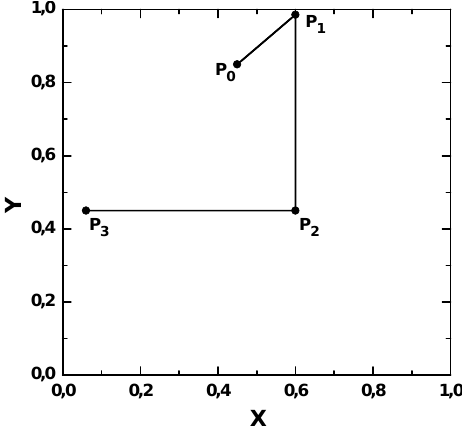
Fig. 6. Orbit with initial point P 0 = ( 0 . 45 , 0 . 9 , 0 . 1 ) and with α = 0 . 1, (cid:15) = 0 . 7, V 2 = 0 .